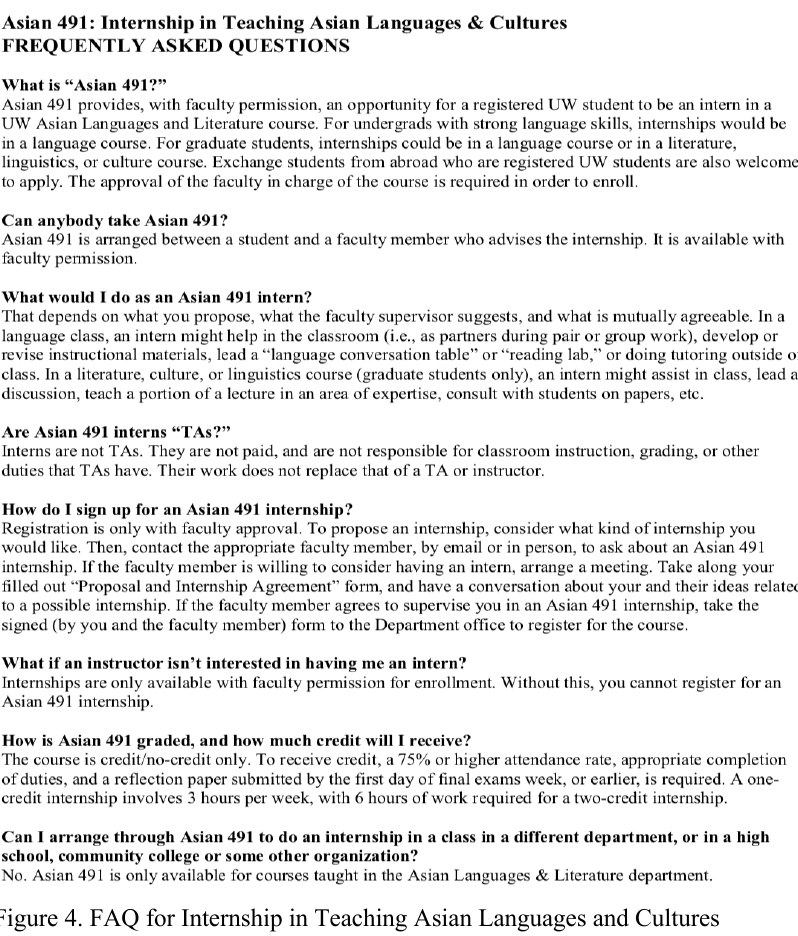
Figure 4. FAQ for Internship in Teaching Asian Languages and